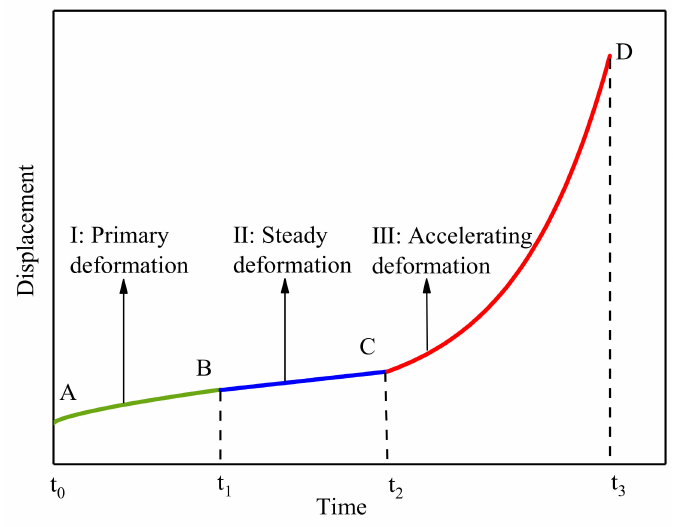
Figure 2. Three-stage deformation curve of a progressive landslide (after Saito